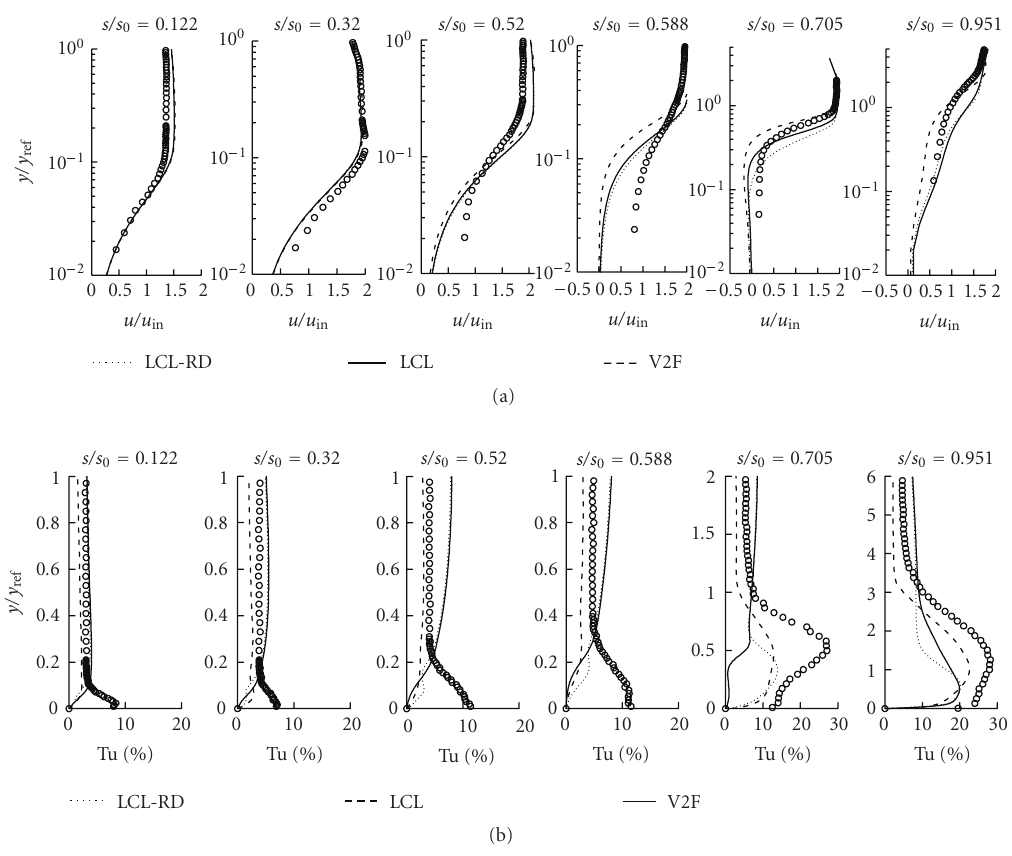
Figure 11: Velocity and turbulence profiles on the suction side for the periodically disturbed